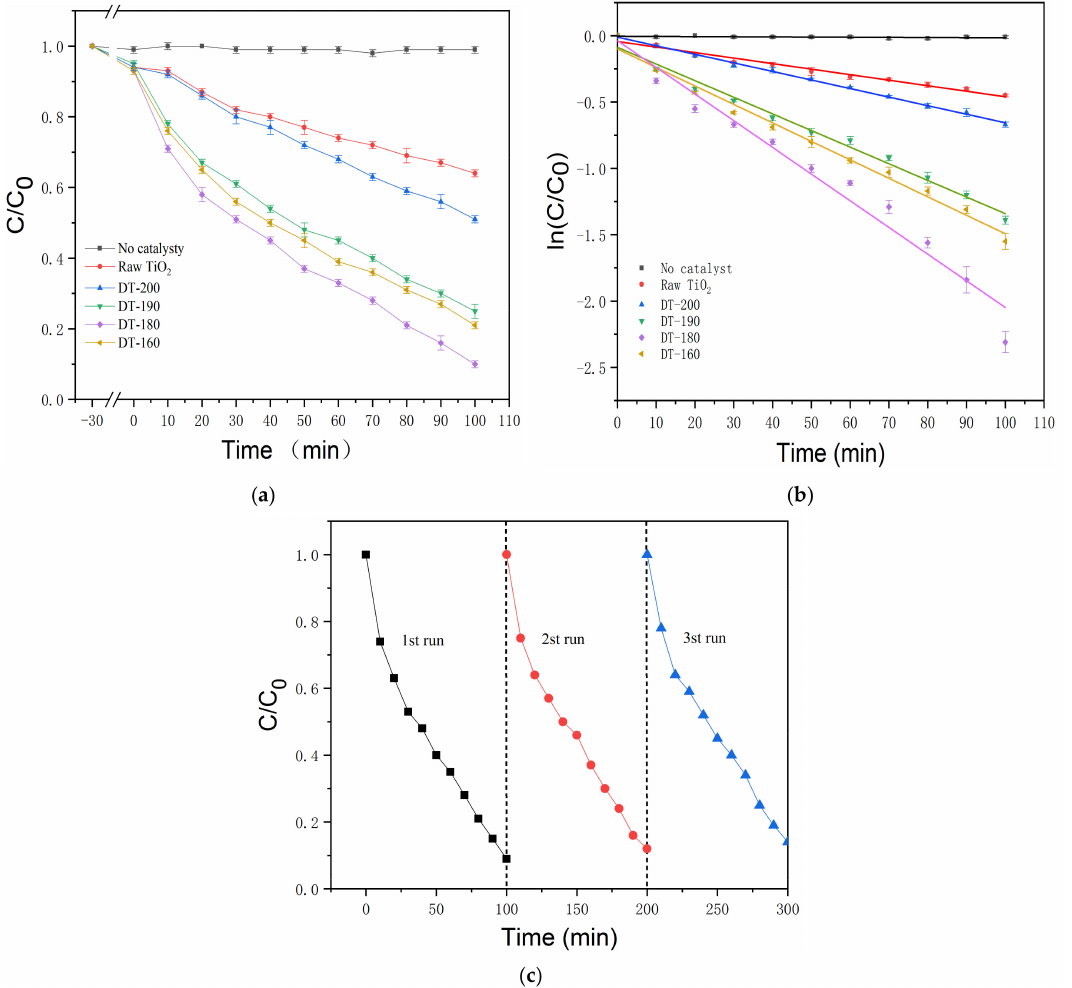
Figure 4. ( a ) Photocatalytic degradation curve; ( b ) Linear fittings of degrading kinetic; ( c ) Recycling performance of the DT-180 for degrading RhB.